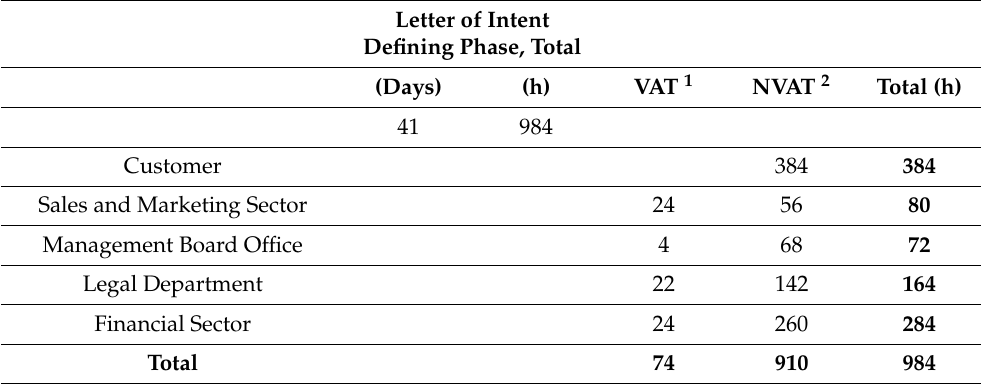
Table A4. The average durations of the Letter of Intent defining phase activities—the current